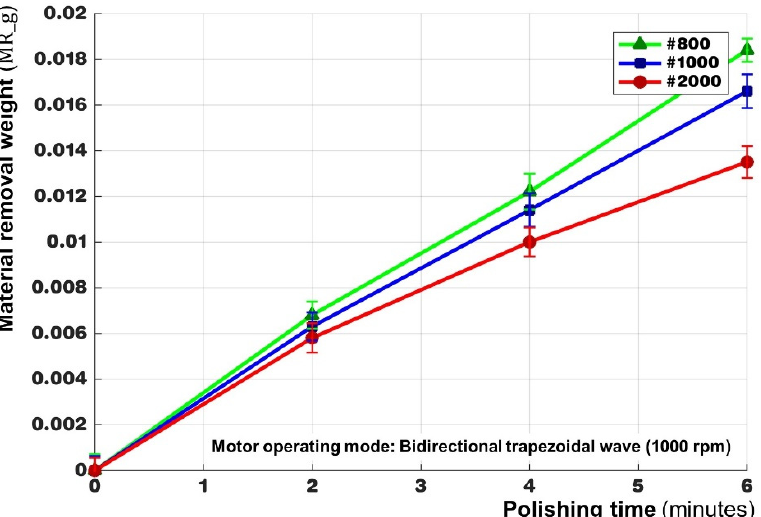
Figure 7. Comparison chart of average surface roughness and polishing time at three motor speeds.